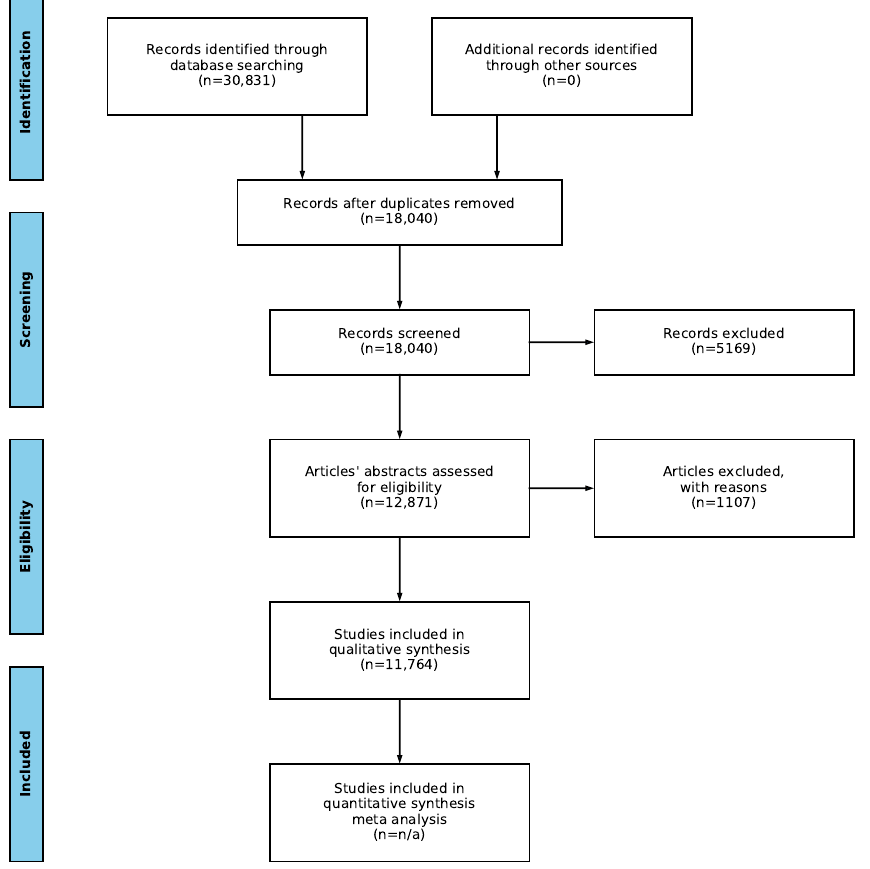
Figure 1. PRISMA statement workflow with total number of articles for the current